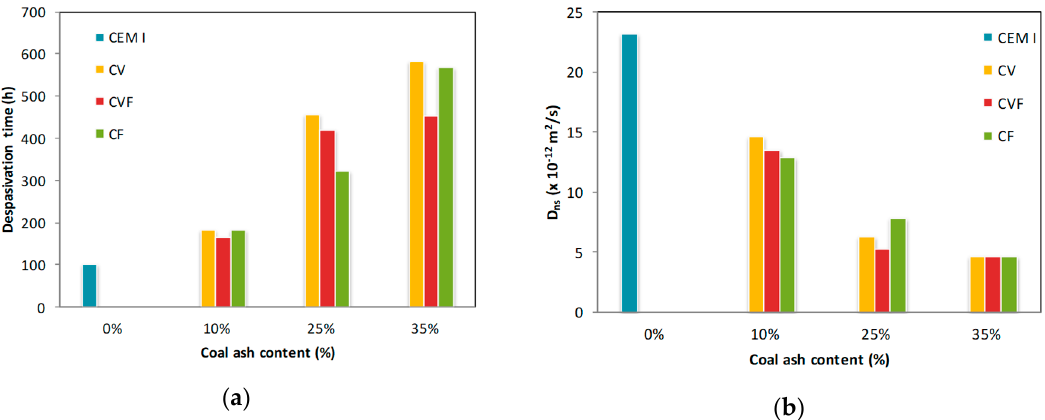
Figure 2. Time (a) and non-steady state (apparent) diffusion coefficient (b) vs. coal ash content. Figure 2. Time ( a ) and non-steady state (apparent) di ff usion coe ffi cient ( b ) vs. coal ash